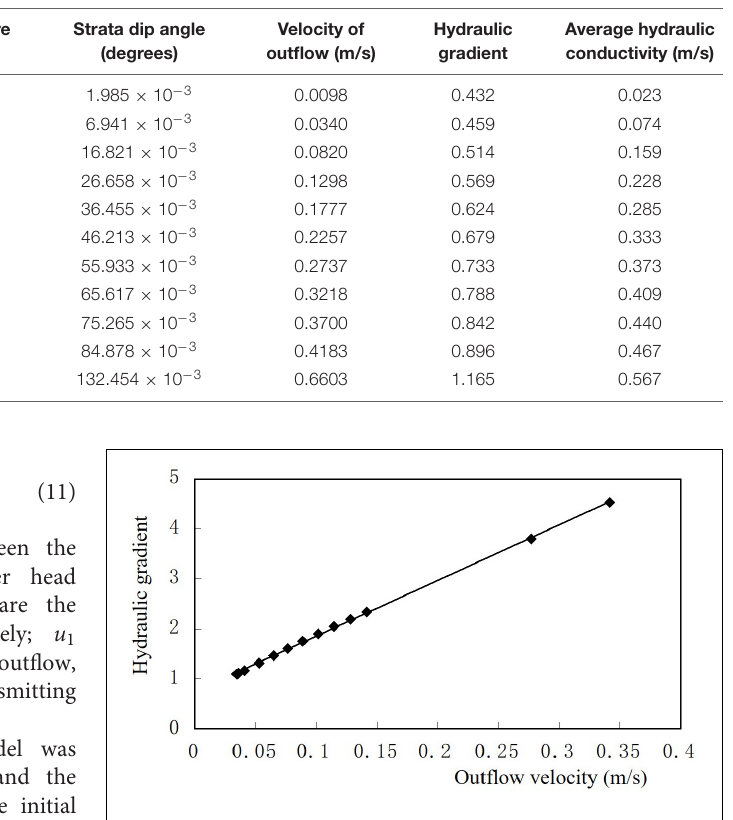
FIGURE 5 | The relationship diagram between the outflow velocity and the hydraulic gradient.